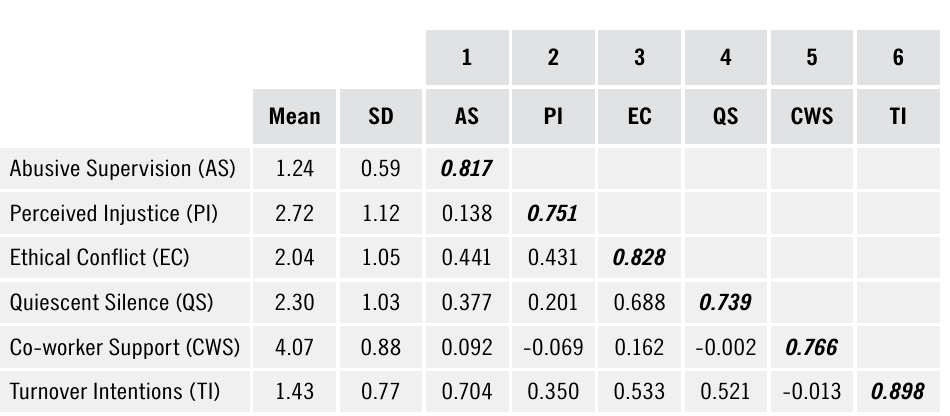
Table 2. Discriminant